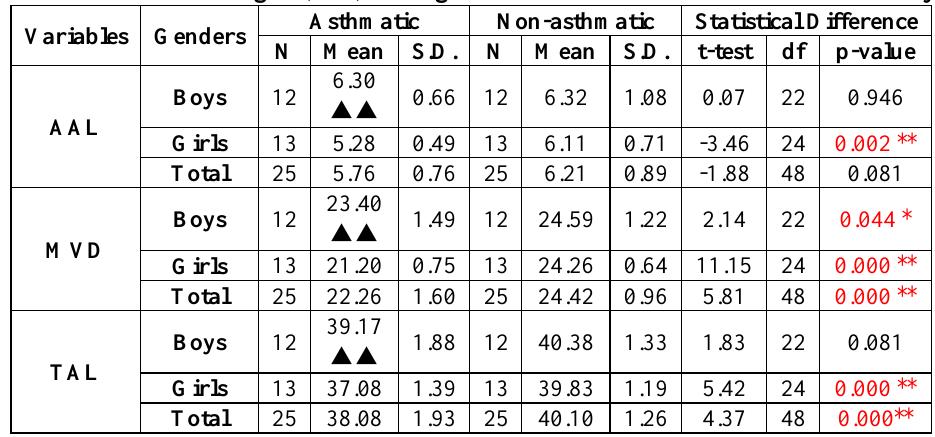
Table 4: Mandibular arch length (mm) among asthmatic and non-asthmatic children by genders Asthmatic Non-asthmatic Statistical Variables Genders